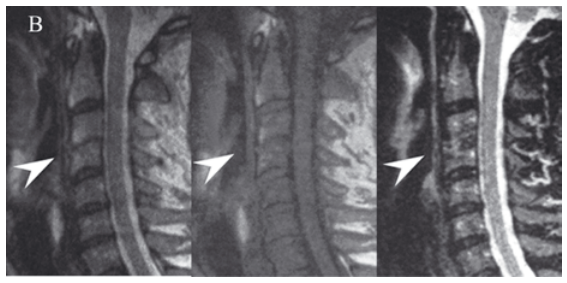
Figure 1. Case 1: A sagittal T1, T2-weighted and TIRM magnetic resonance images at the beginning of the antituberculous treatment.